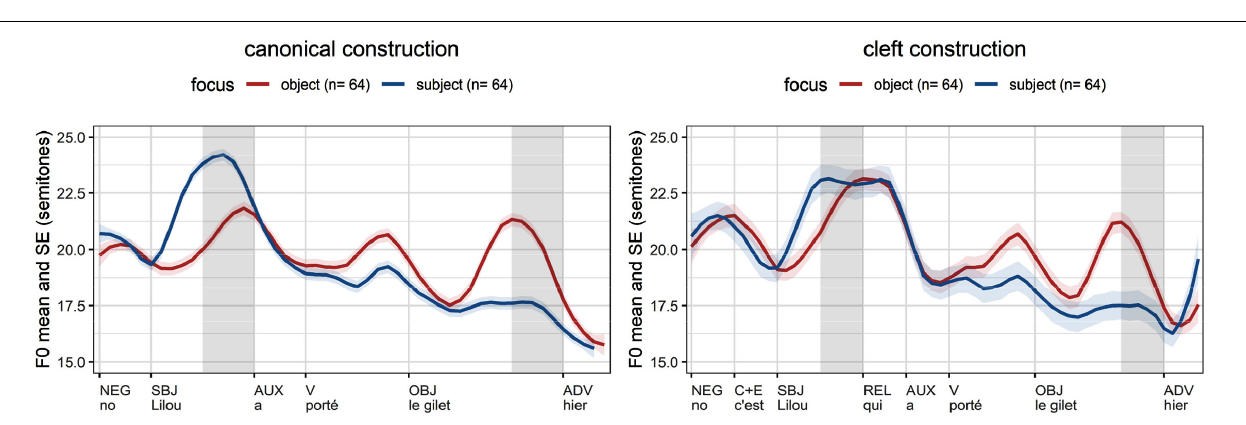
contour tones T2 and T4 that are comparable since they consist of two tonal targets (i.e., T2: LH, T4: HL). All items have the tonal sequence T2-T2 (rise-rise) for subjects and